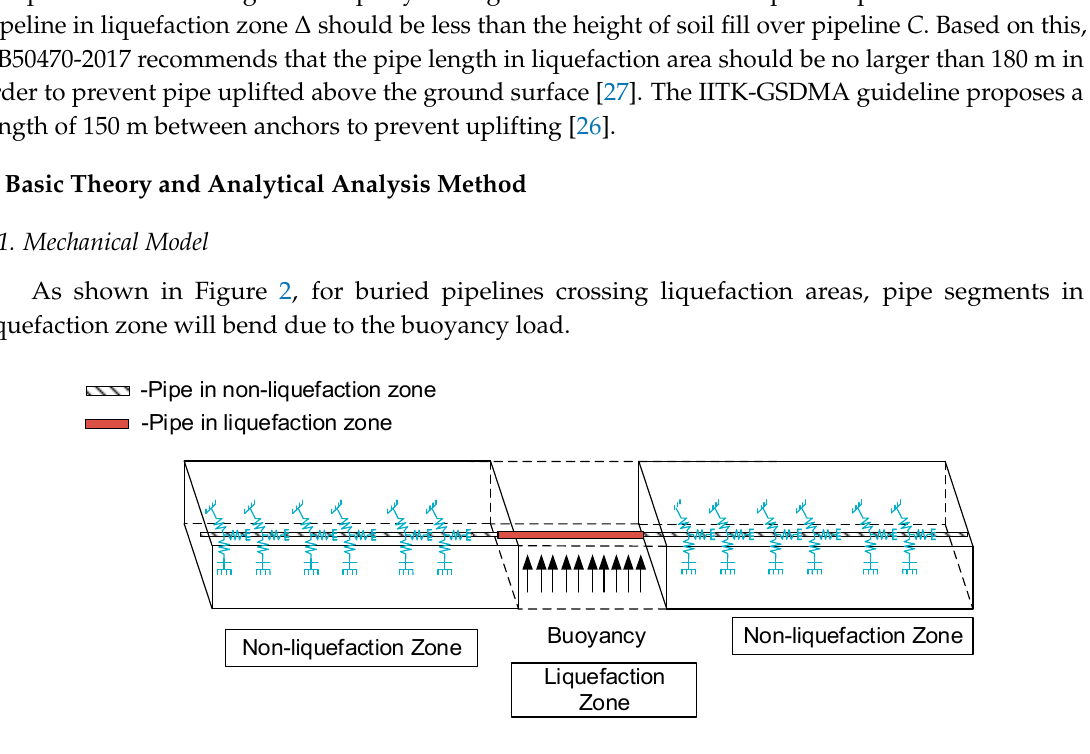
Figure 2. Schematic diagram of buried pipeline crossing liquefaction area.